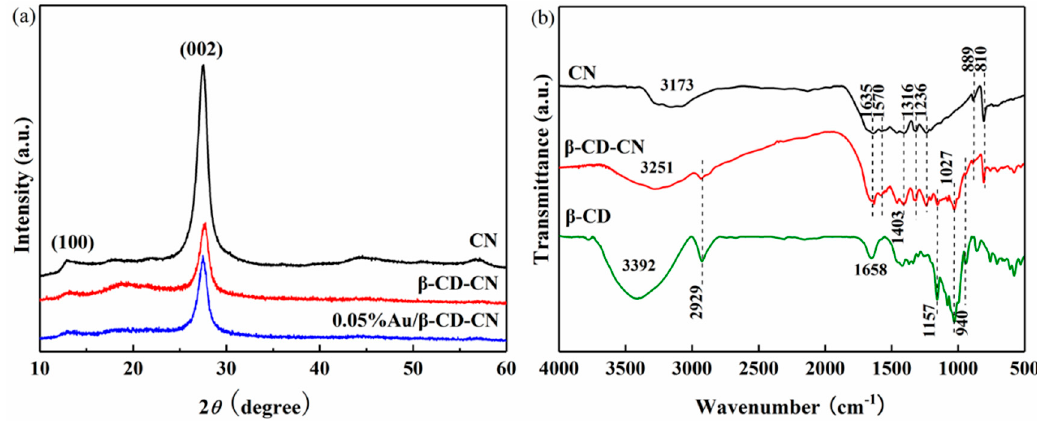
Figure 3. ( a ) X-ray diffraction (XRD) patterns of CN, β -CD-CN, and 0.05% Au/ β -CD-CN; ( b ) Fourier transform infrared (FT-IR) spectra of CN, β -CD-CN, and β -CD.